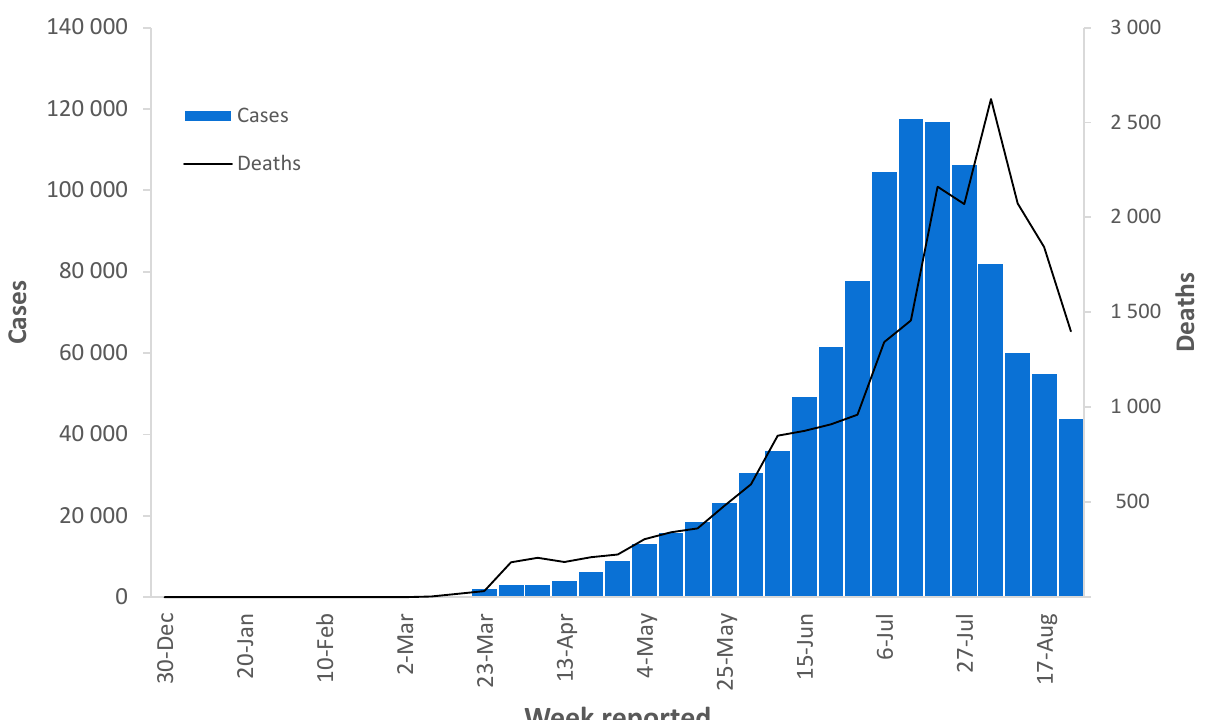
Figure 3: Number of COVID-19 cases and deaths reported weekly by the WHO African Region, data as of 30 August 2020